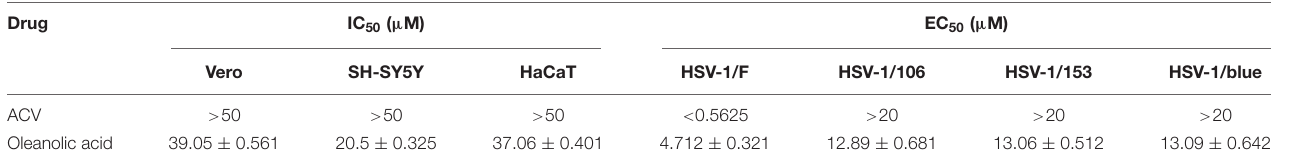
FIGURE 2 | Oleanolic acid inhibits ACV-resistant strains. (A–C) Vero cells were infected with ACV-resistant strains HSV-1/153, HSV-1/106 and HSV-1/Blue (MOI = 1) in the presence of Oleanolic acid or ACV for 72 h, respectively. Plaque assay was performed and the plaque inhibition rate and EC 50 value were calculated. Data are mean ± SD ( n = 2). (D,E) HaCaT cells were treated with HSV-1/153 and HSV-1/106 (MOI = 1) in the presence of Oleanolic acid (20 µ M) or ACV (20 µ M) for 12 and 24 h, respectively. Cell lysates were then subjected to western blot assay to detect the protein levels of viral protein ICP0, VP5, VP16, and gD. GAPDH was used as a loading control. TABLE 1 | Cytotoxic effect and antiviral activity of ACV and Oleanolic acid.